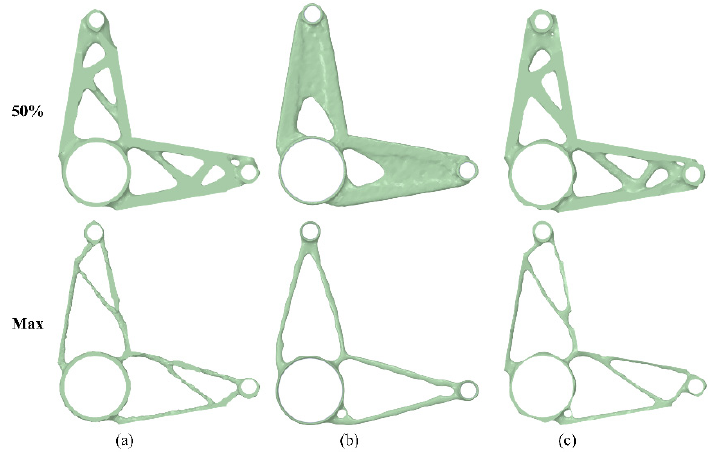
Figure 6. The optimized designs of bell crank lever for 50% and maximum weight reduction in ( a ) SolidWorks, ( b ) ANSYS Mechanical, and ( c ) ABAQUS.